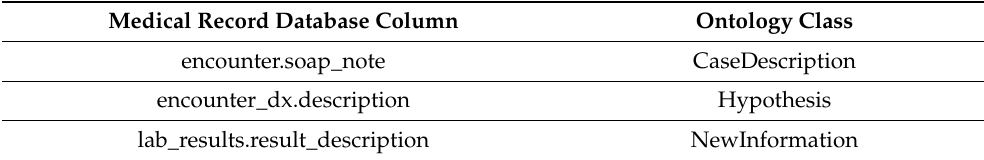
Table 2. Mapping between medical records database and SCT